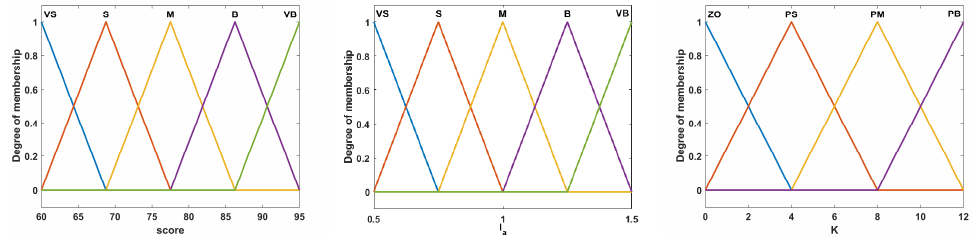
Figure 6. Membership functions for the input and output. Table 2. Fuzzy rule table.